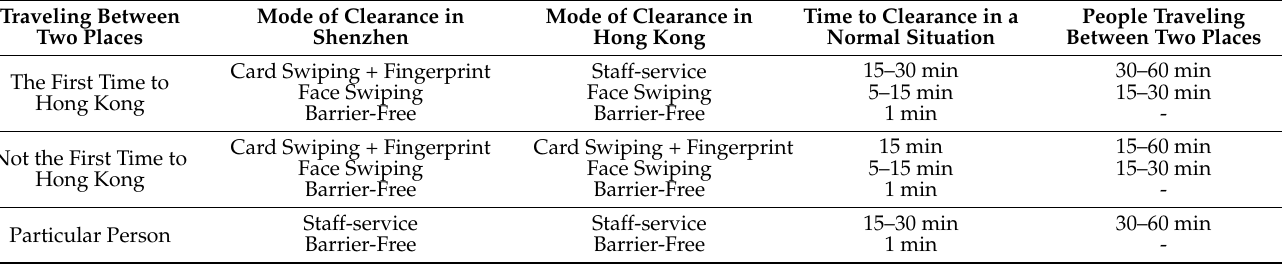
Table 3. Customs clearance inspection method and time in Shenzhen and Hong Kong.